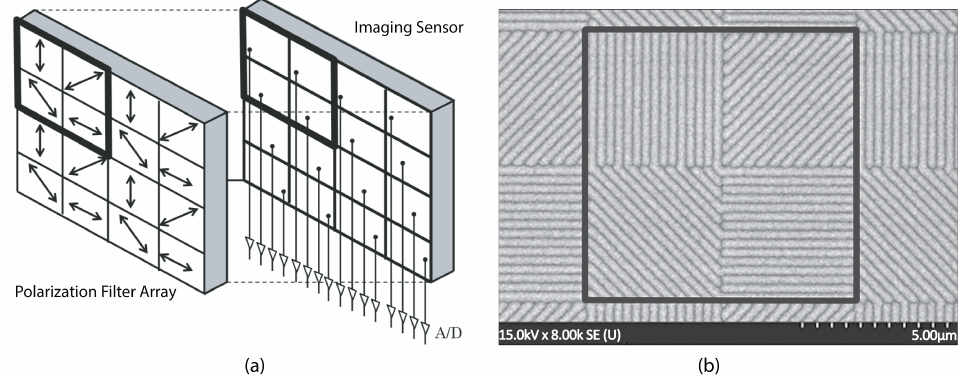
Figure 2. ( a ) Schematic of the basic structural unit of the polarization sensor array. ( b ) SEM image of four neighboring pixels with a micropolarizer